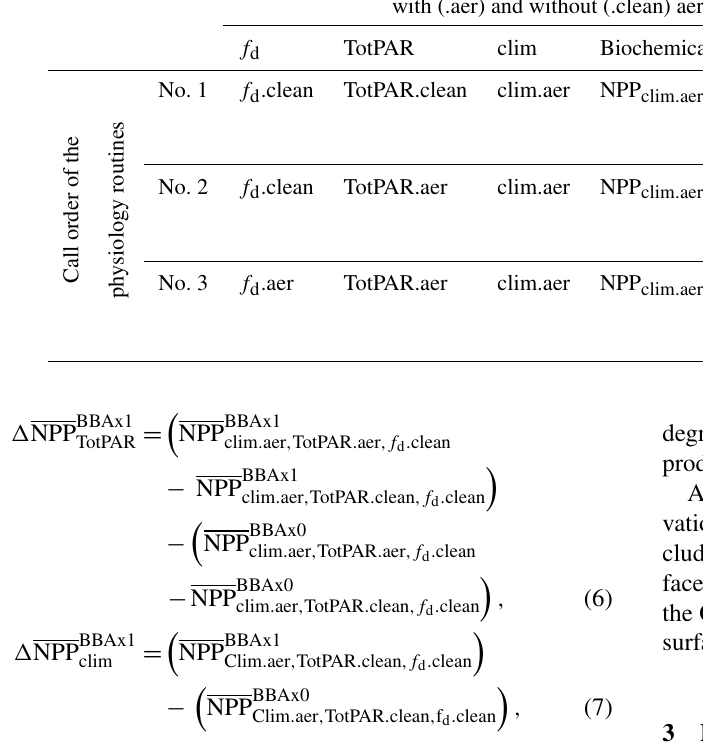
Table 3. Model quantities calculated during the triple call of the physiology routines (see text). Aerosol effect on model variables during the triple call: with (.aer) and without (.clean) aerosol effect f d TotPAR clim Biochemical flux diagnostic (e.g. NPP)